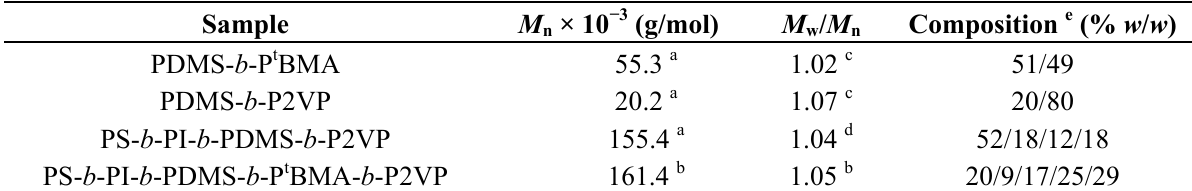
3. Molecular characteristics of poly(dimethylsiloxane) (PDMS) containing block polymers. Sample M × 10 − 3 (g/mol) M / M Composition e (% w / w ) n w n PDMS- b -P t BMA 55.3 a 1.02 c 51/49 PDMS- b -P2VP 20.2 a 1.07 c 20/80 PS- b -PI- b -PDMS- b -P2VP 155.4 a 1.04 d 52/18/12/18 PS- b -PI- b -PDMS- b -P t BMA- b -P2VP 161.4 b 1.05 b